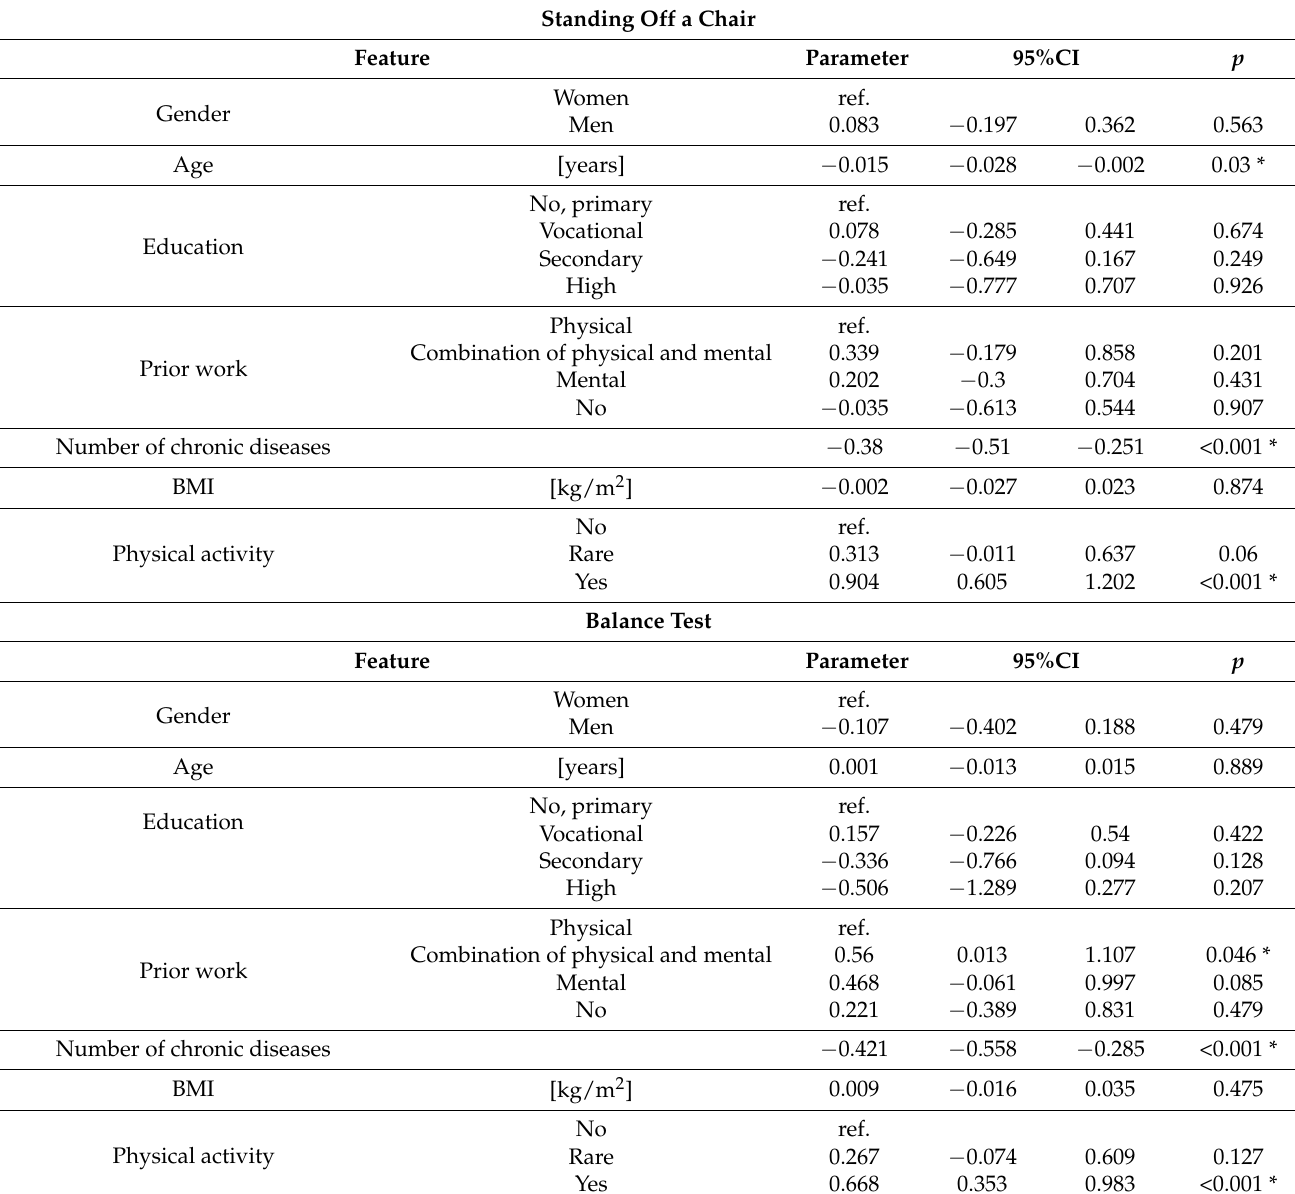
Table 7. Direct predictors of ‘standing off a chair’, walking speed at 4 m distance’ and ‘balance test’ trials. Standing Off a